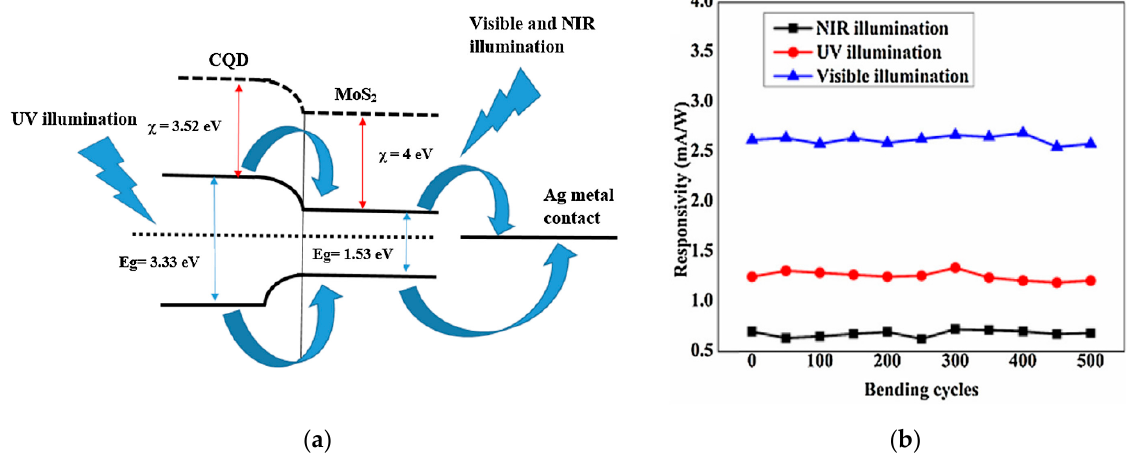
Figure 11. ( a ) Electronic band structure alignment for a photodetector based on MoS2 and CQDs. ( b ) Responsivity values of the device over the bending cycle numbers, demonstrating the stability of the signal over multiple bending cycles. Reprinted with permission from ref. [52]. © 2018, Elsevier.